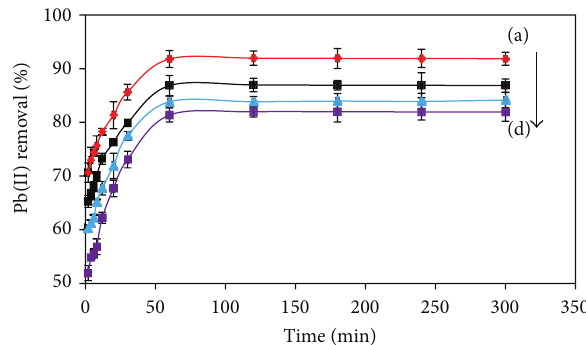
Figure 5: Effect of adsorbent dosage on lead adsorption by activated maize tassel (contact time: 60min; dosage 1.2g; initial concentration 10mg/L; error bar = ± S.D.; and 𝑛 = 3